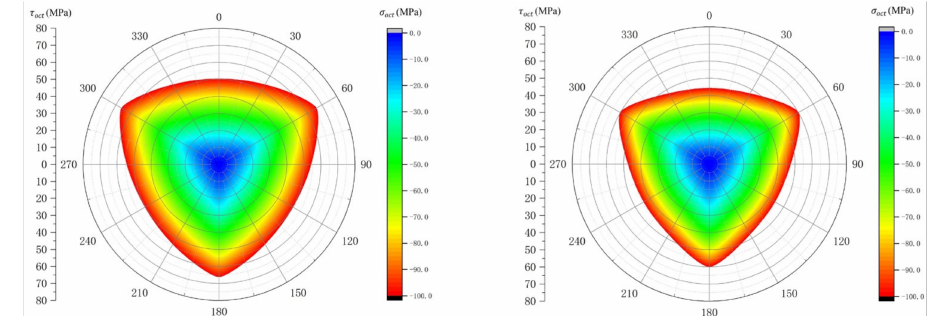
Figure 10. Deviatoric plane of the Ottosen ( left ) and Guo Wang ( right ) criterion.